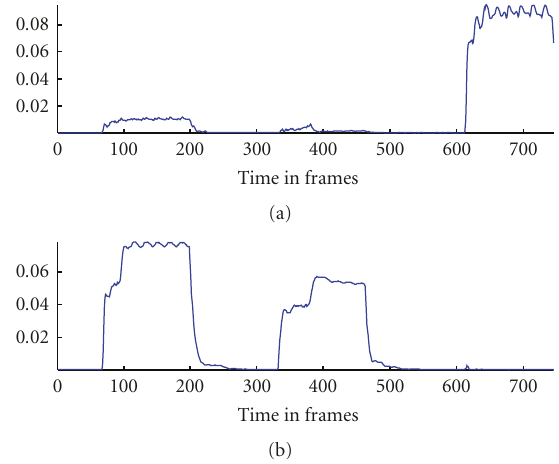
Figure 4: The visualisation of row vectors of H o for rank R =